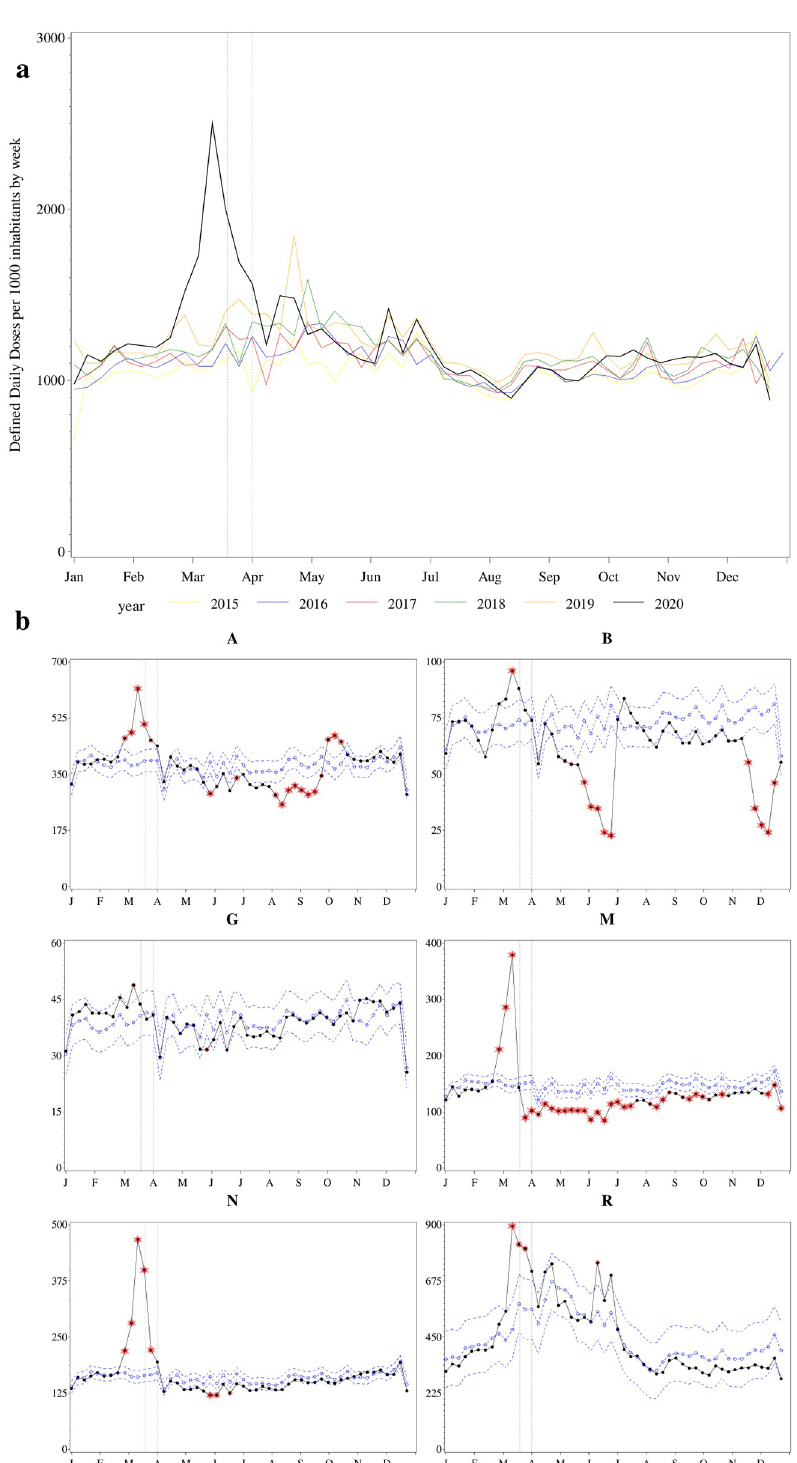
Fig 3. (a) Volume of defined daily doses sold of over-the-counter medication per 1000 inhabitants by week, 2015– 2020, Sweden; (b) Observed versus predicted weekly volume of defined daily doses sold of over-the-counter medication per 10000 inhabitants by ATC anatomical main group, 2020, Sweden. Note: The vertical lines indicate the weeks containing March 19th and April 1st 2020 when limits on medication sales were recommended and then mandated, respectively. P-values that remain significant after Bonferroni correction are marked. Legend: solid black